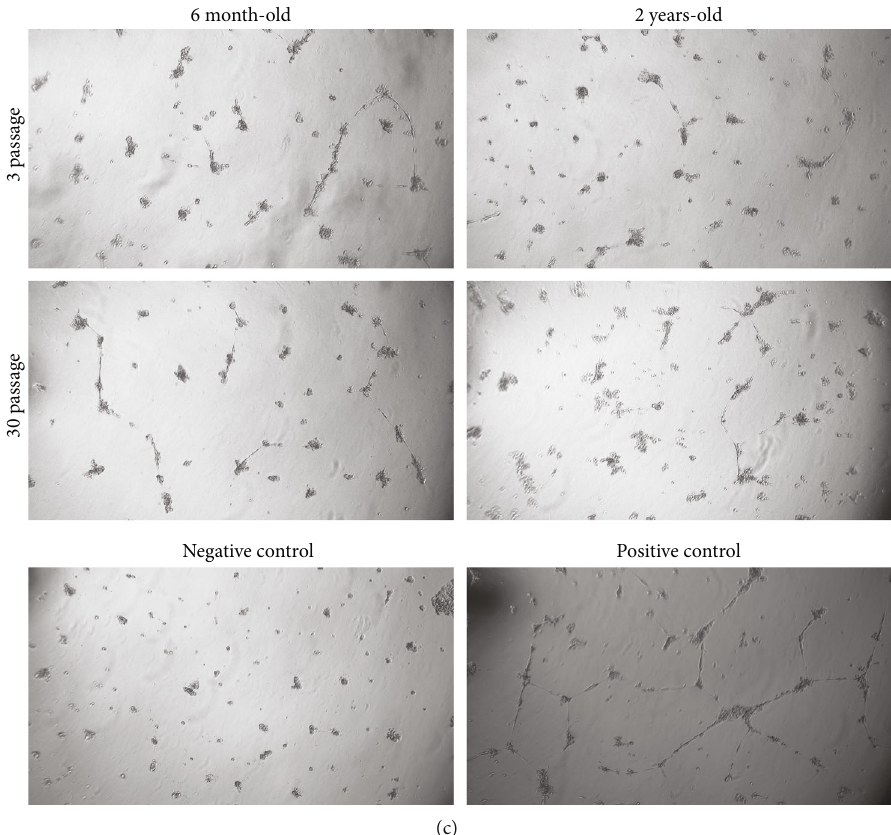
Figure 4: (a) Tubule formation by Matrigel-cultured ASCs from 6mth rats, p. 3; 2yrs. rats, p. 3; 6mth rats, p. 30; 2yrs. p. 30 and HUVEC cell culture as a control; (b) tubule-like structures emerging from spheroids cultured in collagen gel: ASC and HUVEC (control); mean numbers of the tubules produced by spheroids composed by ASCs from 6mth and 2 yrs. donors, short-term (3 p.) and long-term (30 p.) in vitro culture. HUVEC spheroids served as controls. ∗ p < 0 : 05 ; total length of tubules per spheroids composed by ASCs from 6mth and 2yrs. donors, short-term (3 p.) and long-term (30 p.) in vitro culture. HUVEC spheroids served as controls. ∗ p < 0 : 05 ; mean tubule length produced by spheroids composed by ASCs from 6 mth and 2 yrs. donors, short-term (3 p.) and long-term (30 p.) in vitro culture. HUVEC spheroids served as controls. ∗ p < 0 : 05 ; (c) HUVEC-produced tubules in Matrigel stimulated by supernatants from cultures of ASCs from 6mth donors, p. 3; 2 yrs. donors, p. 3; 6mth donors, p. 30; 2yrs. donors, p. 30. Negative controls were HUVEC cultures in EGM − 2 + 0 : 5 % FBS; positive controls were HUVEC cultures in EGM − 2 + 20 %